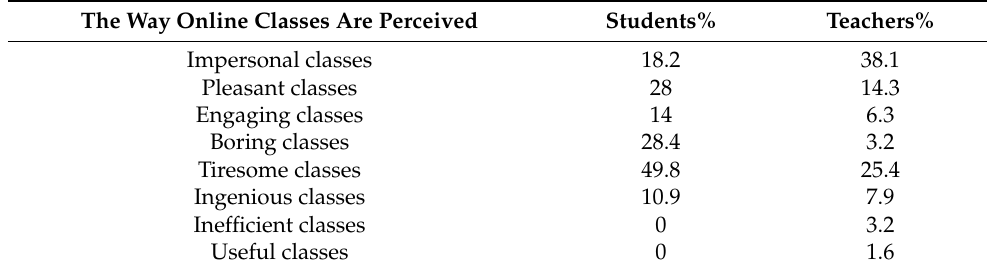
Table 13. The way online classes are